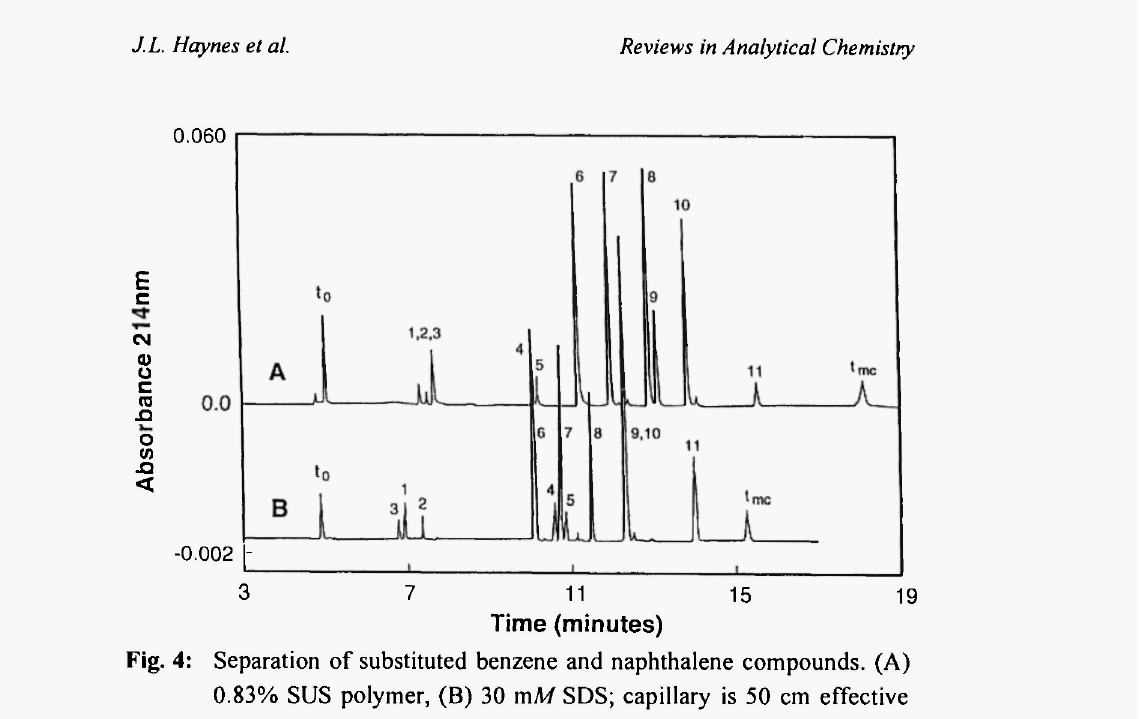
Fig. 4: Separation of substituted benzene and naphthalene compounds. (A) 0.83% SUS polymer, (B) 30 mΜ SDS; capillary is 50 cm effective length and 57 cm total length, 16.1 kV applied potential. A phosphate-borate buffer at pH 7.3 was employed; 1 = nitrobenzene, 2 = anisole, 3 = /?-nitroaniline, 4 = o-xylene, 5 = /«-xylene, 6 = naphthylamine, 7 = naphthalenemethanol, 8 = acenaphthenol, 9 = naphthalene, 10 = naphthaleneethanol, 11 = diphenyl ether. From 725/ with